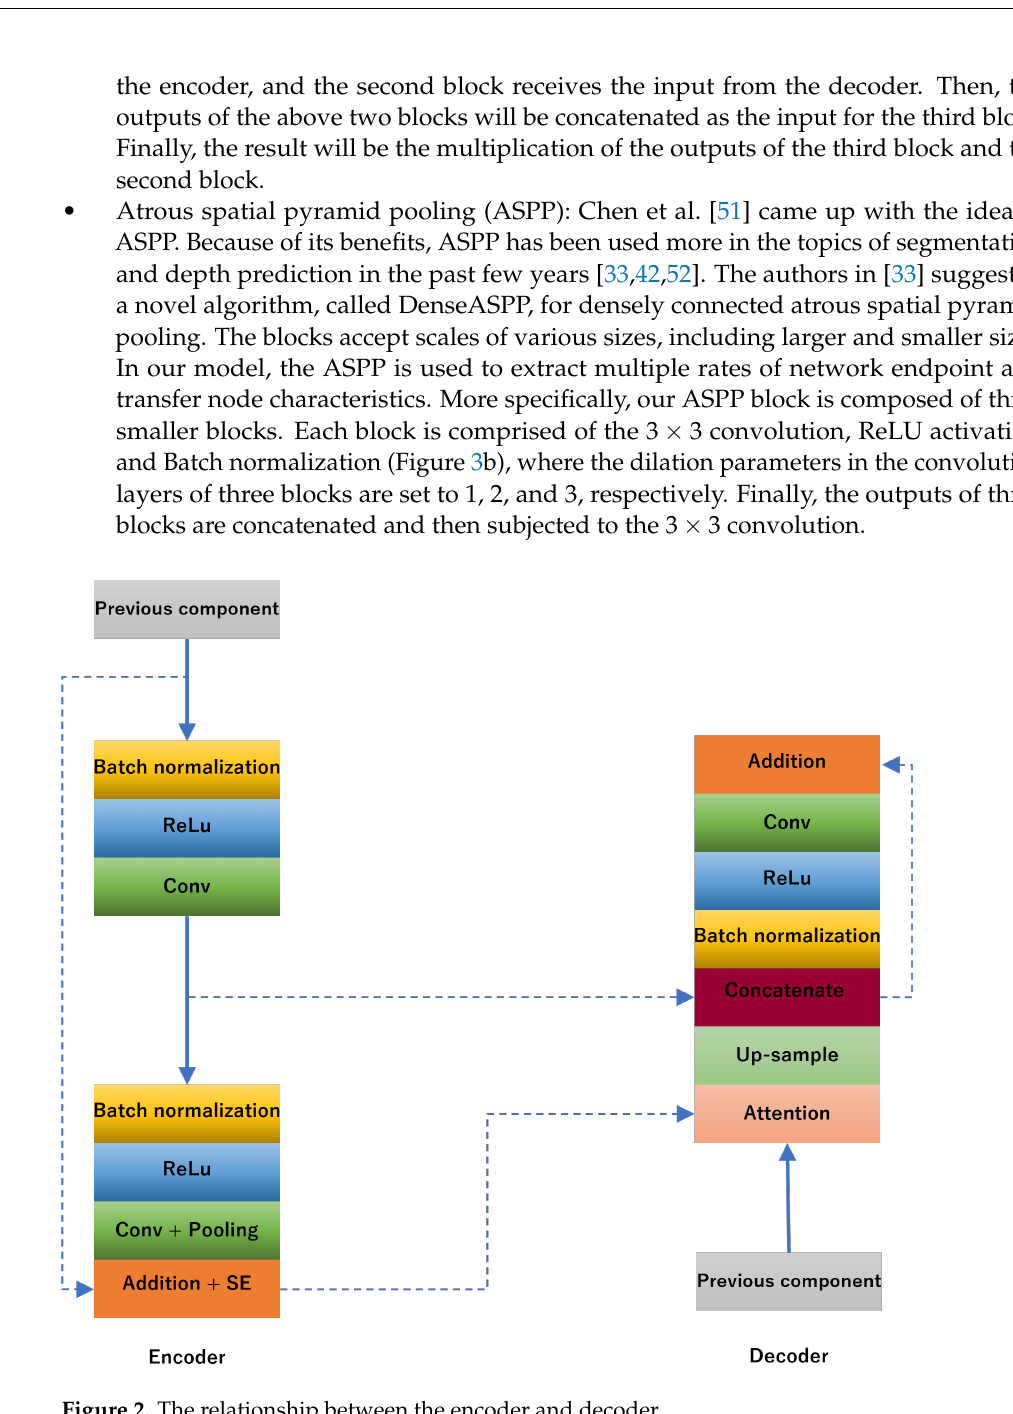
Figure 2. The relationship between the encoder and